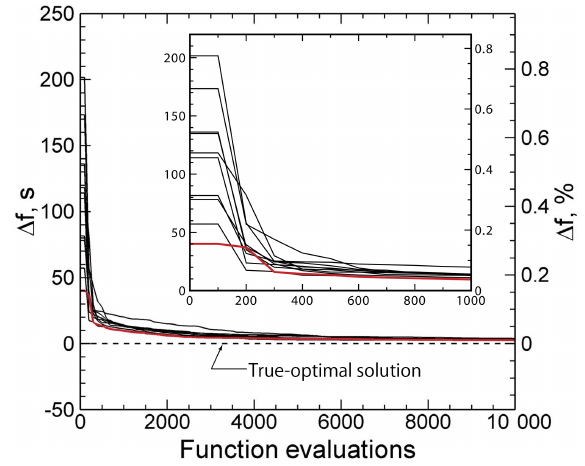
Figure 10. Flight time vs. number of function evaluations ( = n p × n g ), including the enlarged drawing in the early 1000 evaluations. The population size n p is 100 and the number of generations n g is 100. (cid:49)f means the difference in flight time between the solution f and the true-optimal solution f true ( = 25994 . 0s). The (cid:49)f (in %) is calculated as ((cid:49)f/f true ) × 100. The solution shown as red line corresponds to the best solution in Figs. 7 to 9. Table S1 summarizes the 10 optimal solutions in